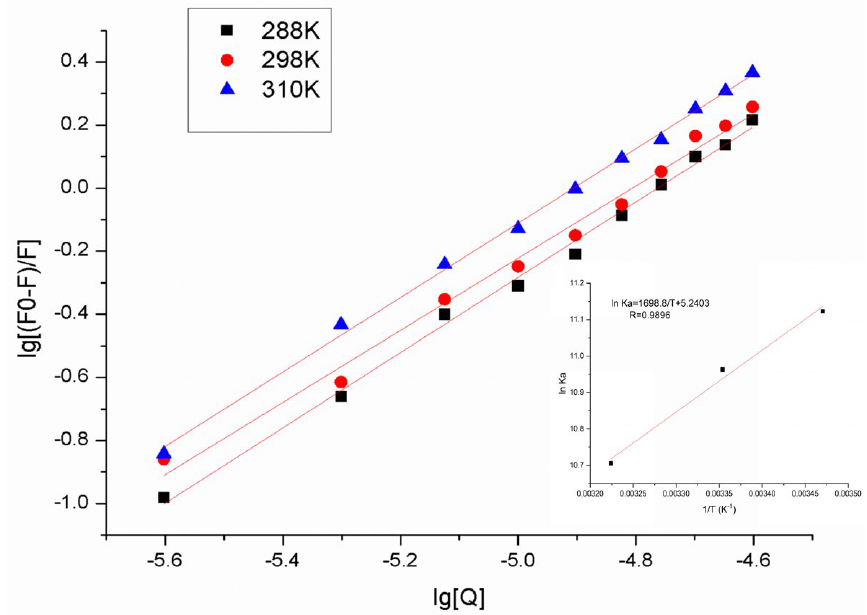
Figure 3. Scatchard diagram of astilbin–HSA system at different temperatures. The insert corresponds to the Van’t Hoff plot for the interaction of astilbin and HSA. Table 2. Binding constants (K a ), the number of binding site (n) and relative thermodynamic param- eters of the HSA–astilbin system at three temperatures.